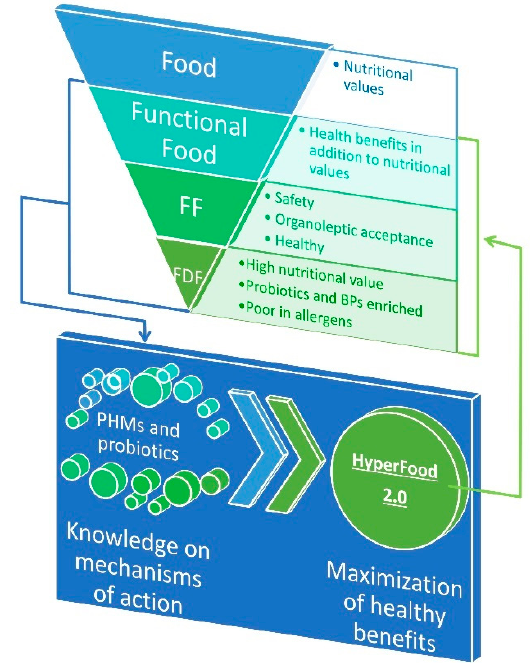
Figure 1. Position of fermented dairy food (FDF) in food consortium and strategies for